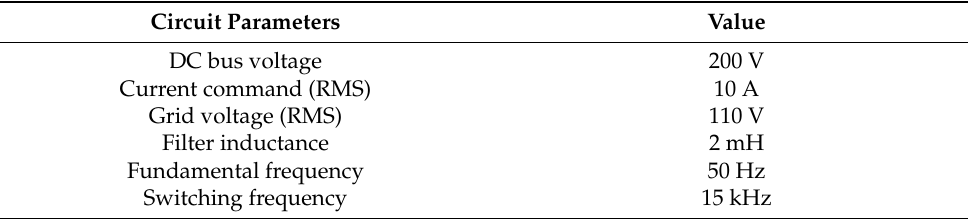
Figure 5. Experimental prototype of grid-connected inverter. Table 1. Values of parameters for grid-connected